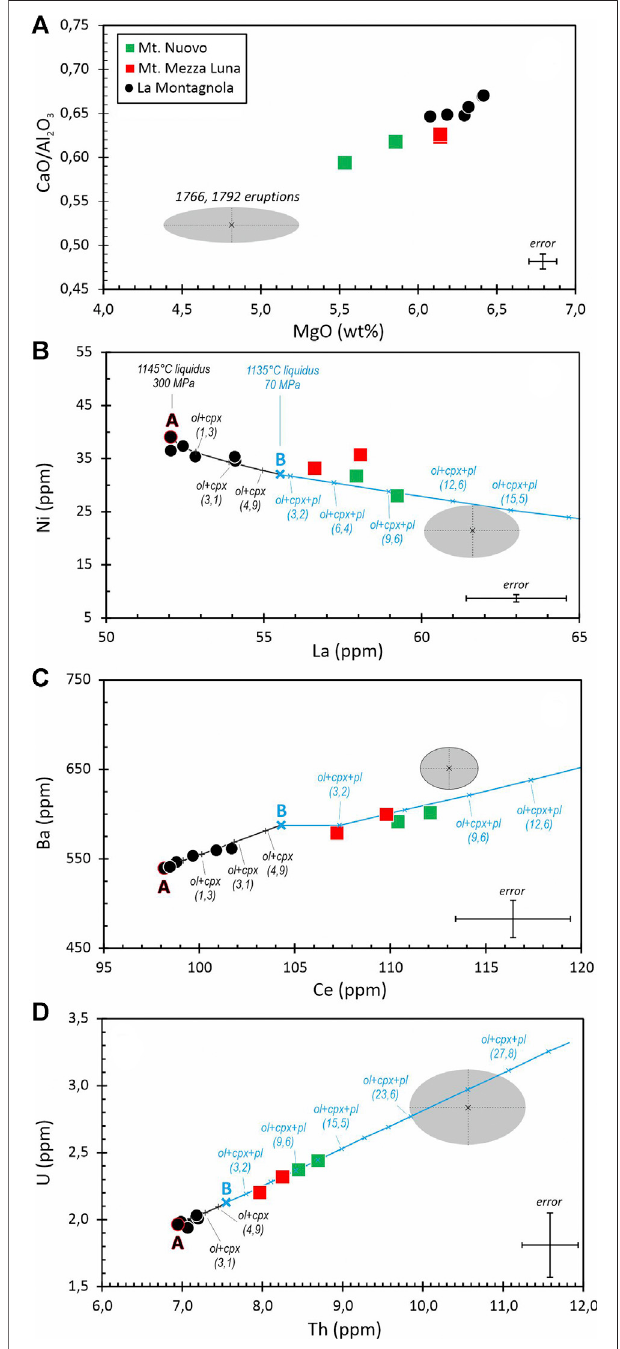
FIGURE 5 | Variations of MgO versus CaO/Al 2 O 3 (A) , La versus Ni (B) , Ce versus Ba (C) and Th versus U (D) in thevolcanic productsof Mt. MezzaLuna and Mt.Nuovo.DataofLaMontagnolaeruptionarefromCorsaroetal.(2009).Theliquid evolutionlinesmodelledstartingfromcompositions “ A ” (at300 MPa,blackline) and “ B ” (at 75 MPa, blue line) are drawn (see the text for details). Ticks mark the cumulative volume percentage of the minerals that formed during the fractional crystallizationprocess.Theproductsofthe1766(ViccaroandCristofolini,2008)and 1792 (Corsaro and Cristofolini 1996) eruptions are plotted for comparison; the grey area represents the variability of the analyses expresses as the average ± 1